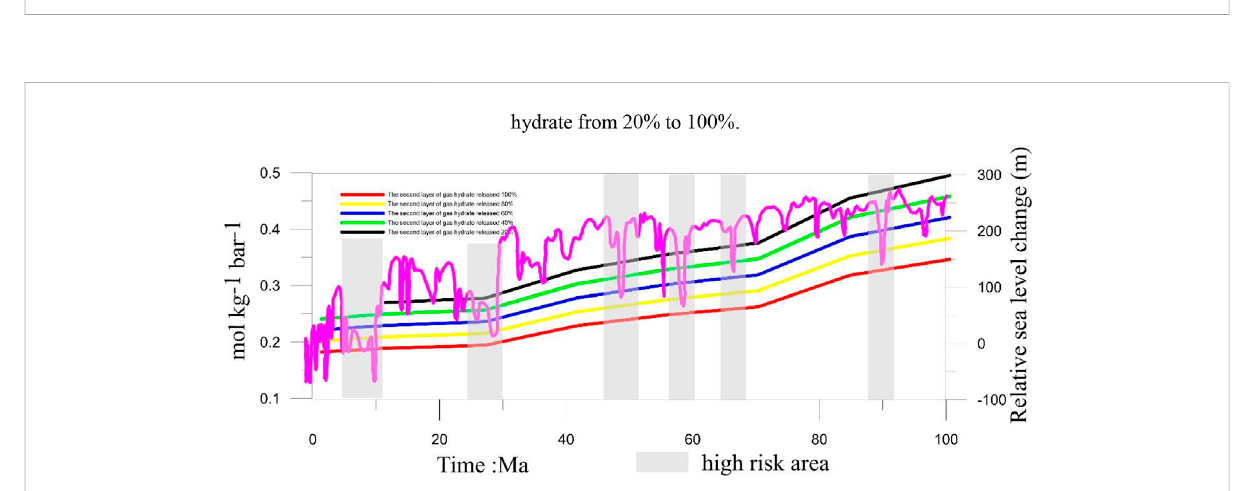
FIGURE 6 Variation in the values from 600 Ma BP under the gradual dissociation of second gas hydrate from 20% to 100%.